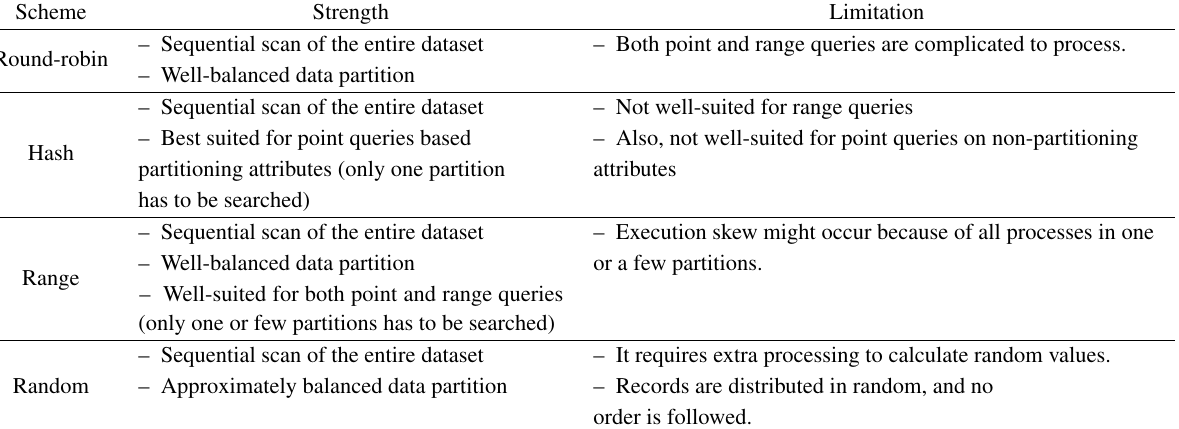
Table 1 A comparison of data partitioning